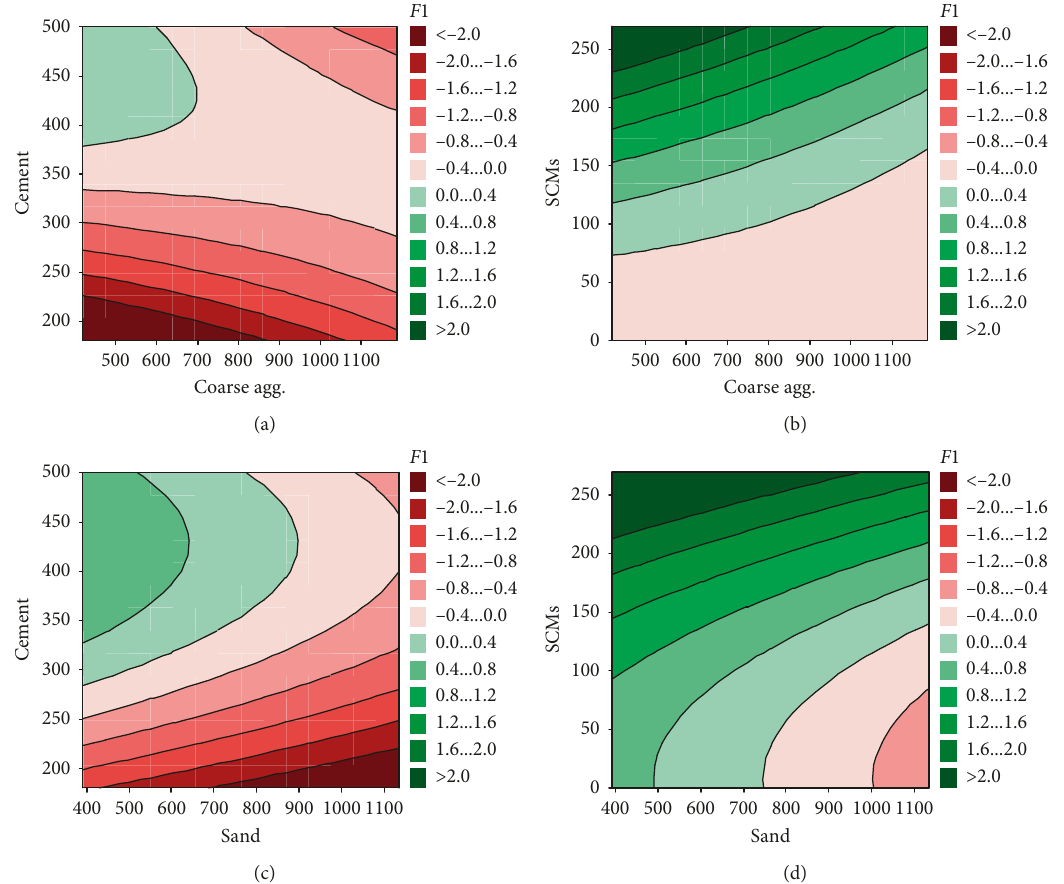
Figure 4: Effect of the amount of aggregates and powders on the quickness of the flow ( F